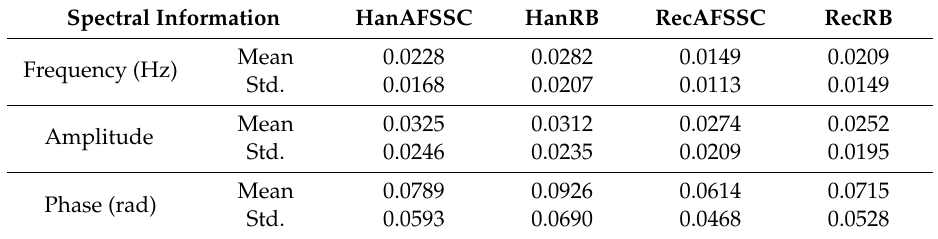
Figure 12. ( a ) Mean values of the estimated errors regarding the harmonic information (frequency, amplitude, and phase) using different spectral correction methods, and ( b ) standard deviations of the estimated errors regarding the harmonic information (frequency, amplitude, and phase) using different spectral correction methods. Table 2. Comparisons of the four techniques when f c = 20.01